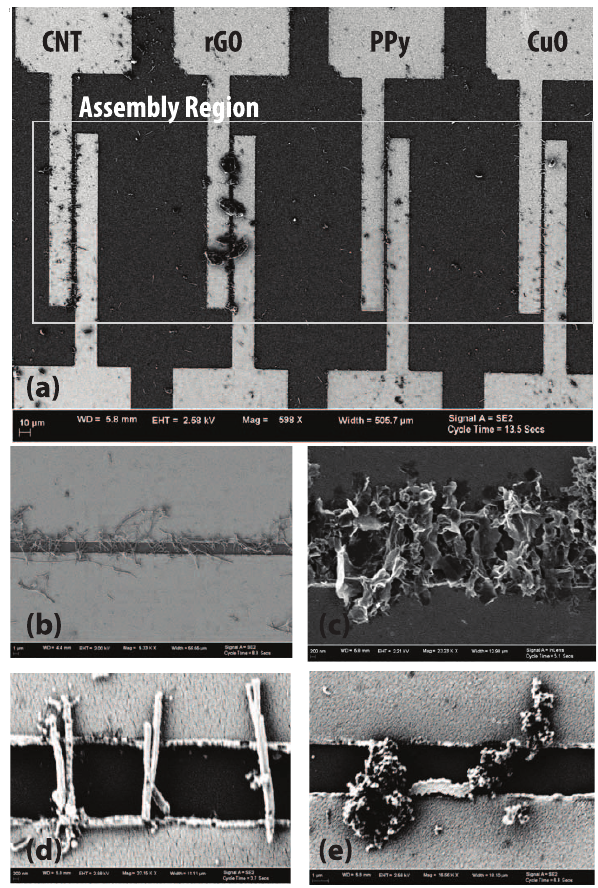
Figure 3. SEM images. (a) Showing four neighboring electrodes from an array assembled with CNT, rGO, PPy and CuO nanomaterials at different electrodes from left to right (b) close up of CNT assemblies (c) close up of rGO flake assemblies (d) close up of CuO nanowire assemblies and (e) close up of polypyrrole assemblies.